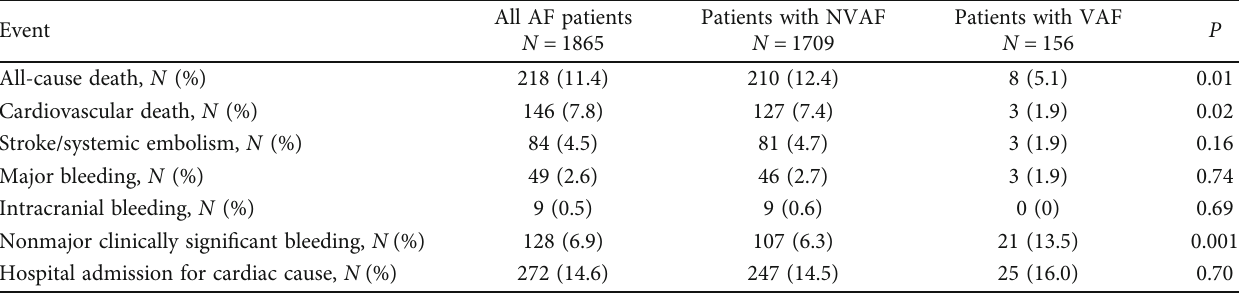
Table 3: One-year outcome in the AF ∗ cohort and the two groups with NVAF and VAF.